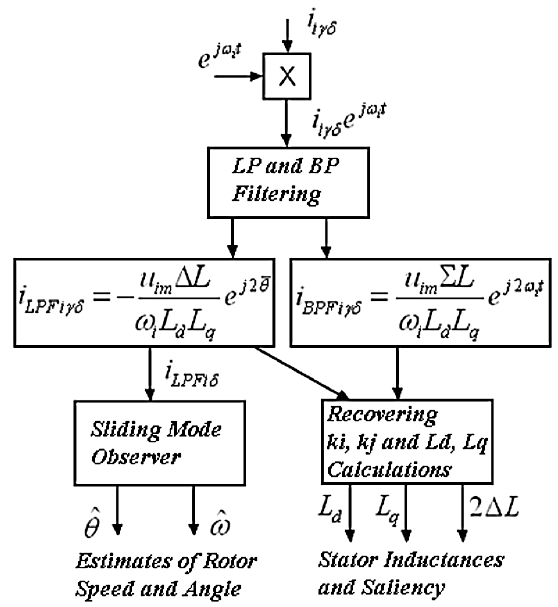
Figure 3. The description of high-frequency (HF) current processing in flow chart form: ( 1 ) stator current modulation, ( 2 ) low-pass and band-pass filtering (LPF, BPF), ( 3 ) speed / position estimation and ( 4 ) inductances and saliency calculation.